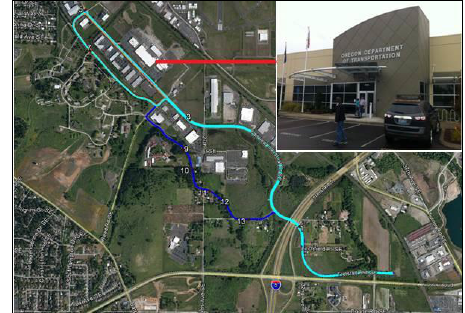
Figure 5. Map of the Oregon DOT MTLS test